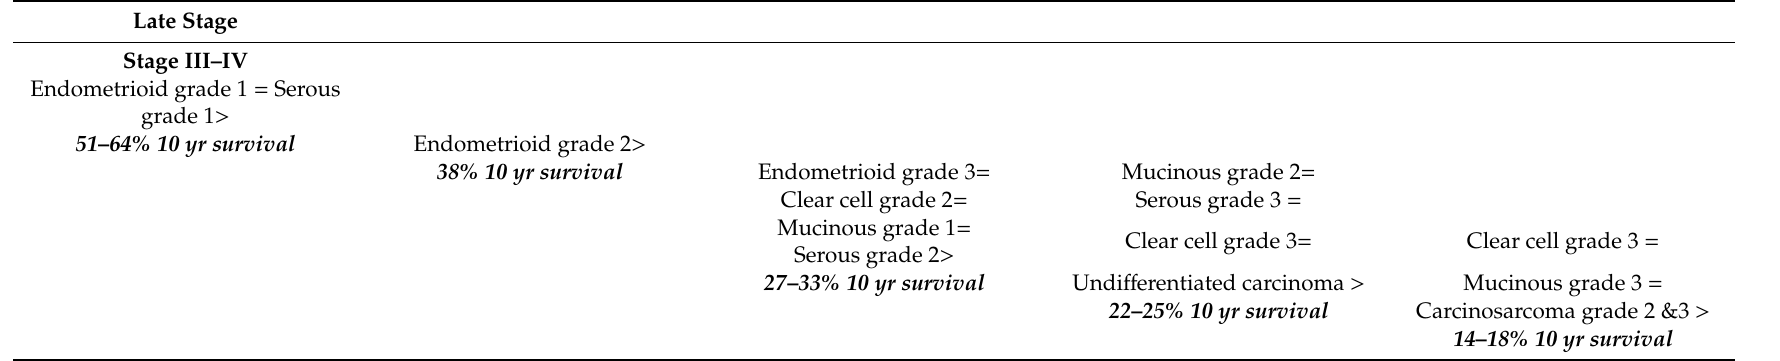
Table 3. DSS Groupings of Late Stage EOC Subtypes Based on Grade. Breakpoints in survival were determined by Log rank test for significant di ff erence of pairs of EOC subtype grades arranged successively. Breakpoints for statistically significant groupings: 51–64%, 38%, 27–33%, 22–25% and < 18% 10-year